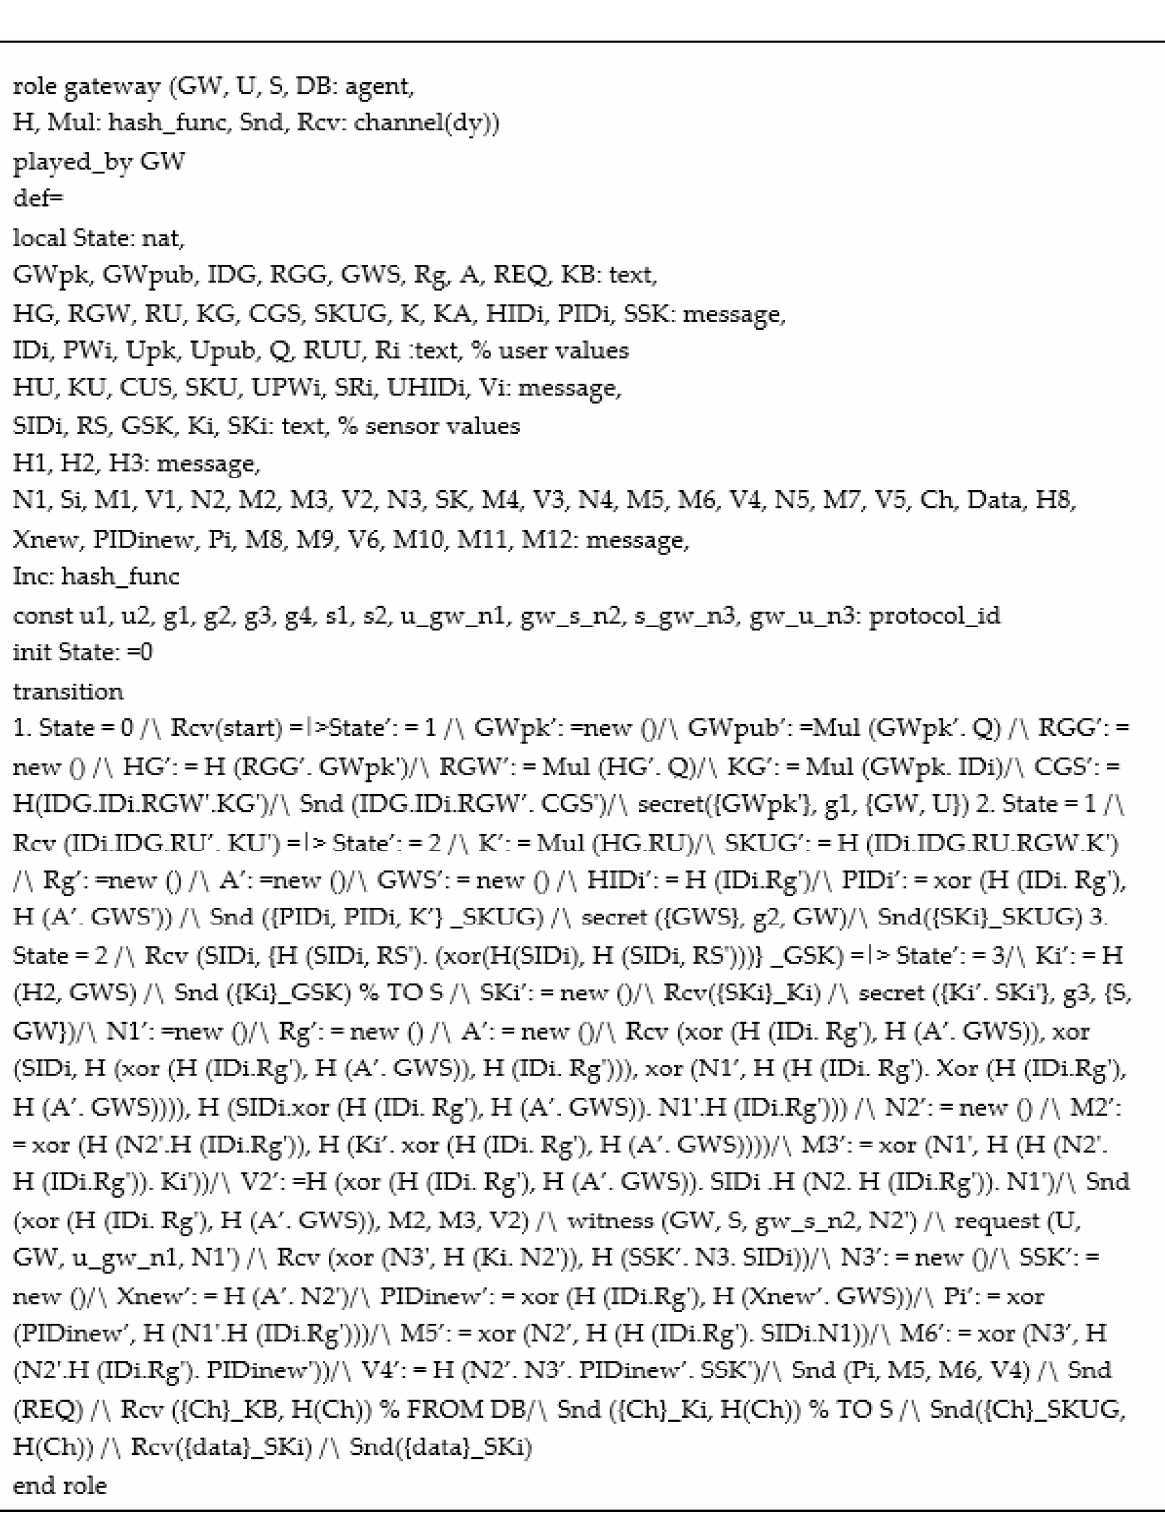
Figure A2. Role of the gateway.